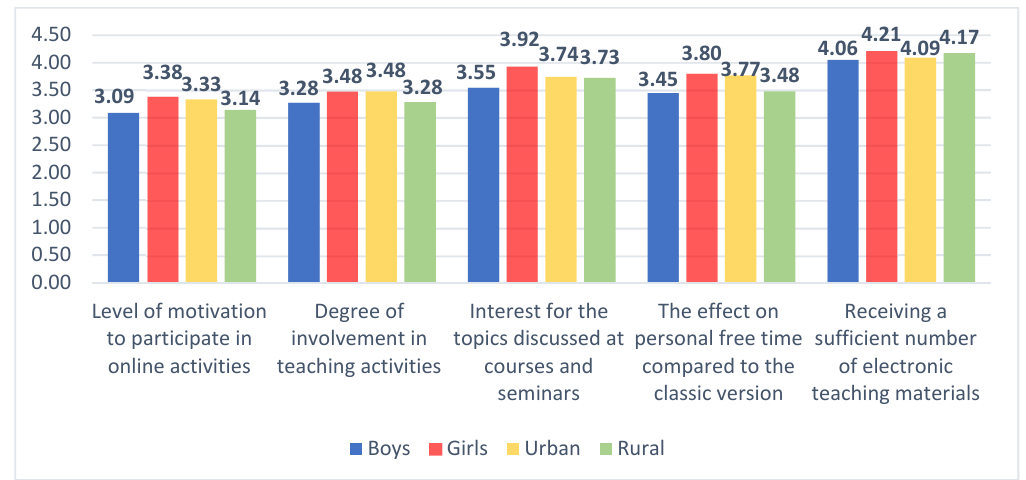
Figure 3. The average values of the answers for the items of the factor motivation. Table 9. Tests of between-subjects effects—the cumulative effect of gender variables * area variables on F4 factor items/efficiency.